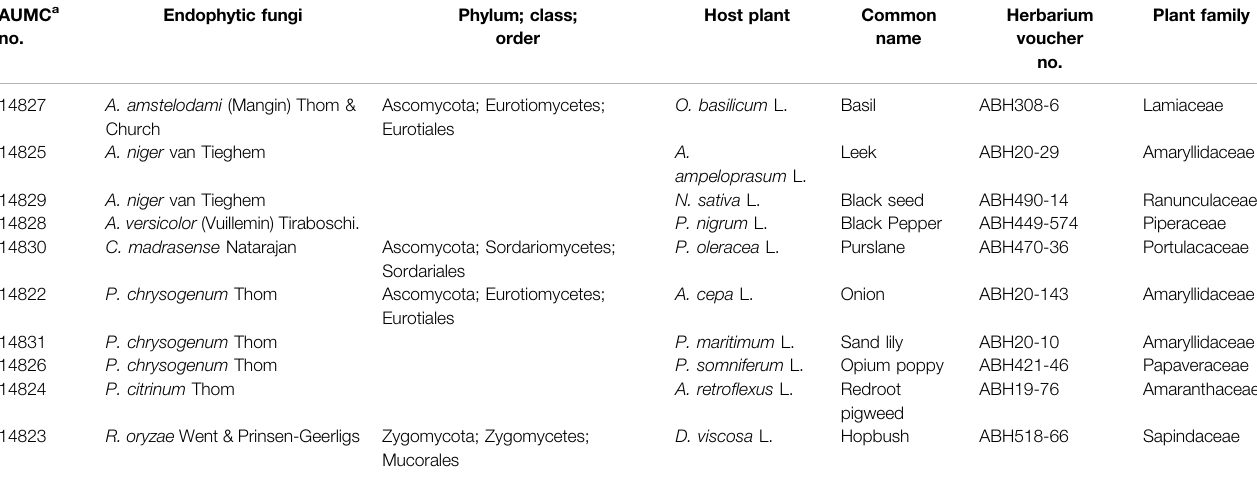
TABLE 1 | Endophytic fungi isolated from different black seed